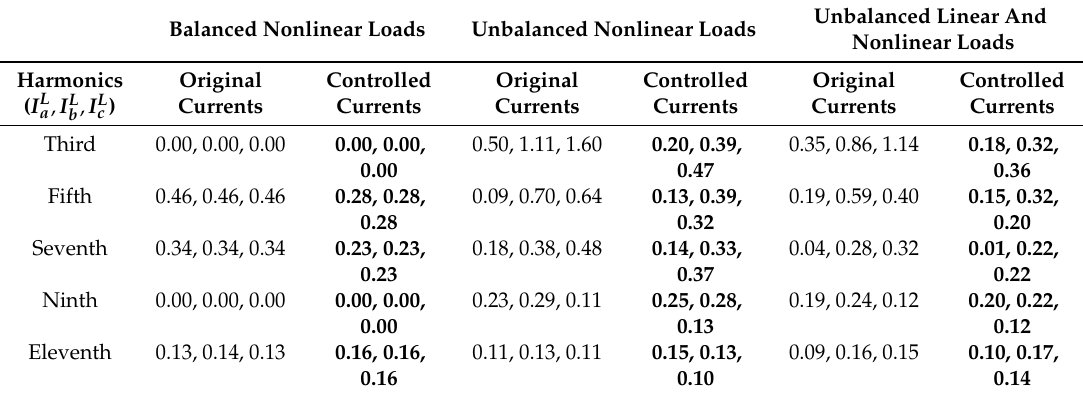
Table 8. Harmonics content attenuated by PI controller tuned by poles placement method.